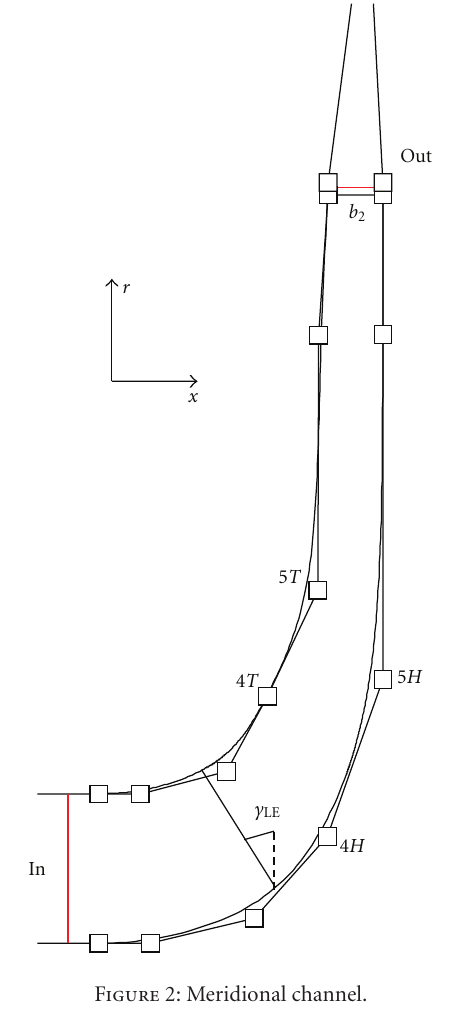
Figure 2: Meridional